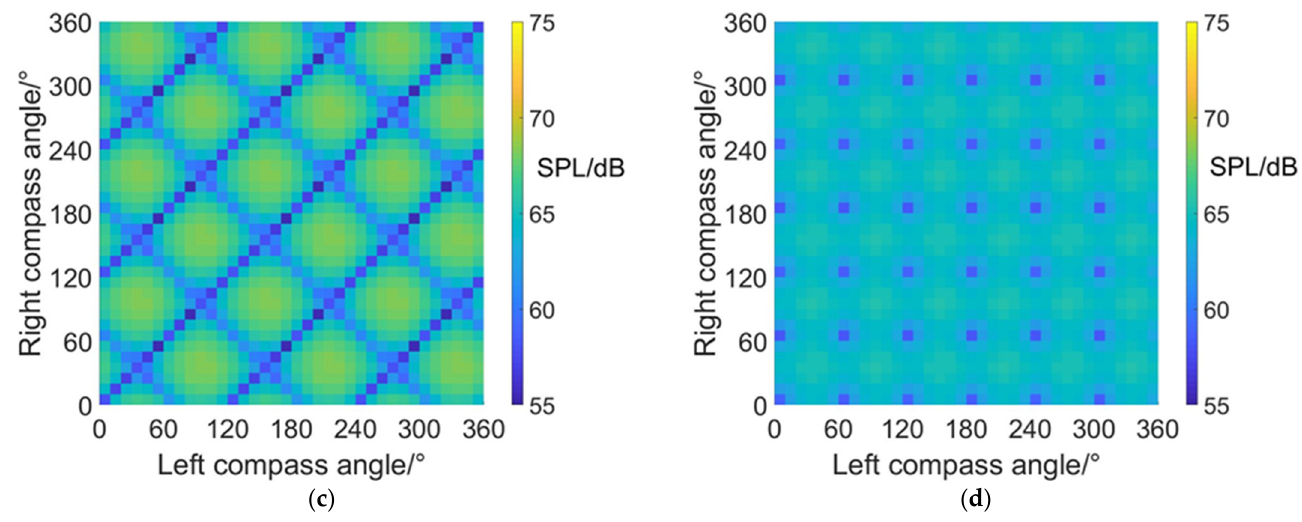
Figure 15. Carpet diagrams of noise SPL in fixed-wing mode at an azimuth angle = 180° with scissors angle difference = ( a ) 0°, ( b ) 30°, ( c ) 60°, ( d ) 90°. Table 8. Maximum and minimum SPL values at an azimuth angle = 0° in fixed-wing mode. Scissors Angle Difference/ ◦